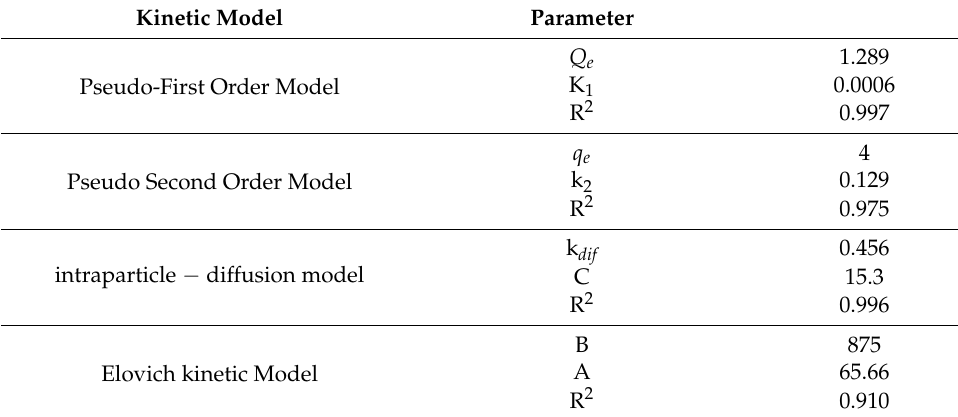
Table 5. Comparison of the kinetics